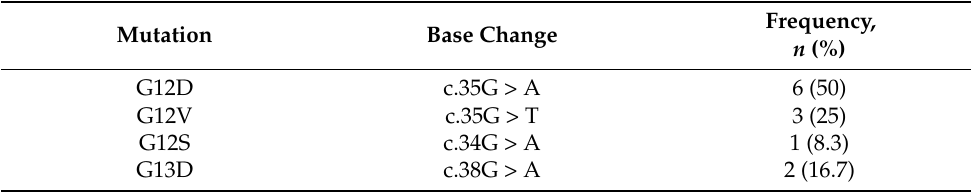
Table 2. Frequency of KRAS